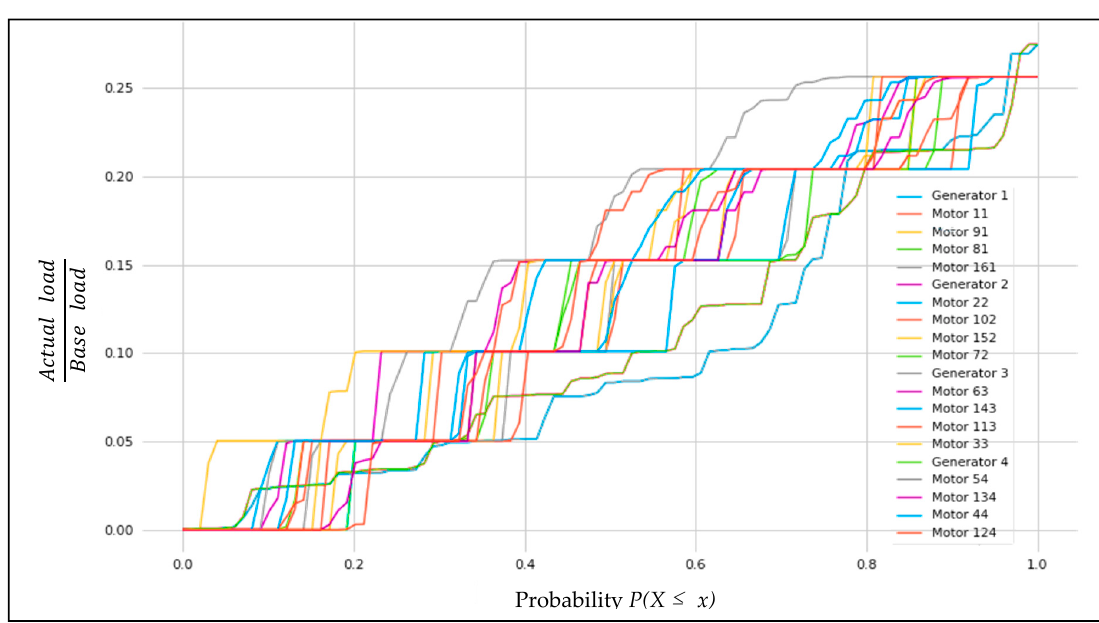
Figure 26. MC RTO branch load probability.